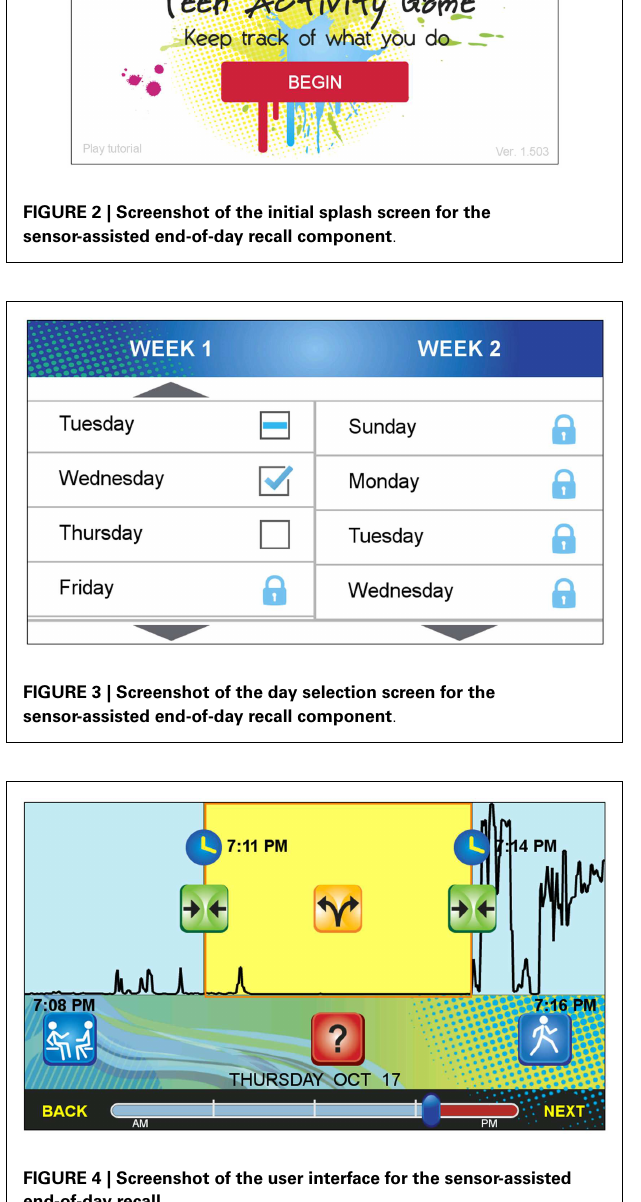
icon, and the three most recently selected activity choices appear at the top of the list in green 3 . The remainder of the activity list is organized alphabetically. Once an activity label is selected for the highlighted bout, the orange question mark button is replaced